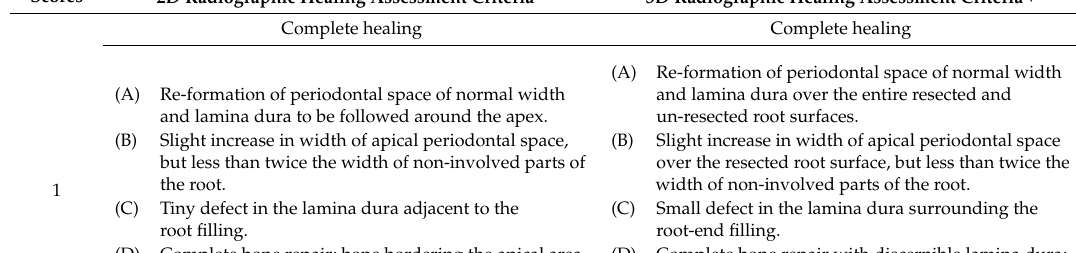
Table 1. A scoring system for 2D and 3D radiographic healing assessment of the endodontic microsurgery. Scores 2D Radiographic Healing Assessment Criteria